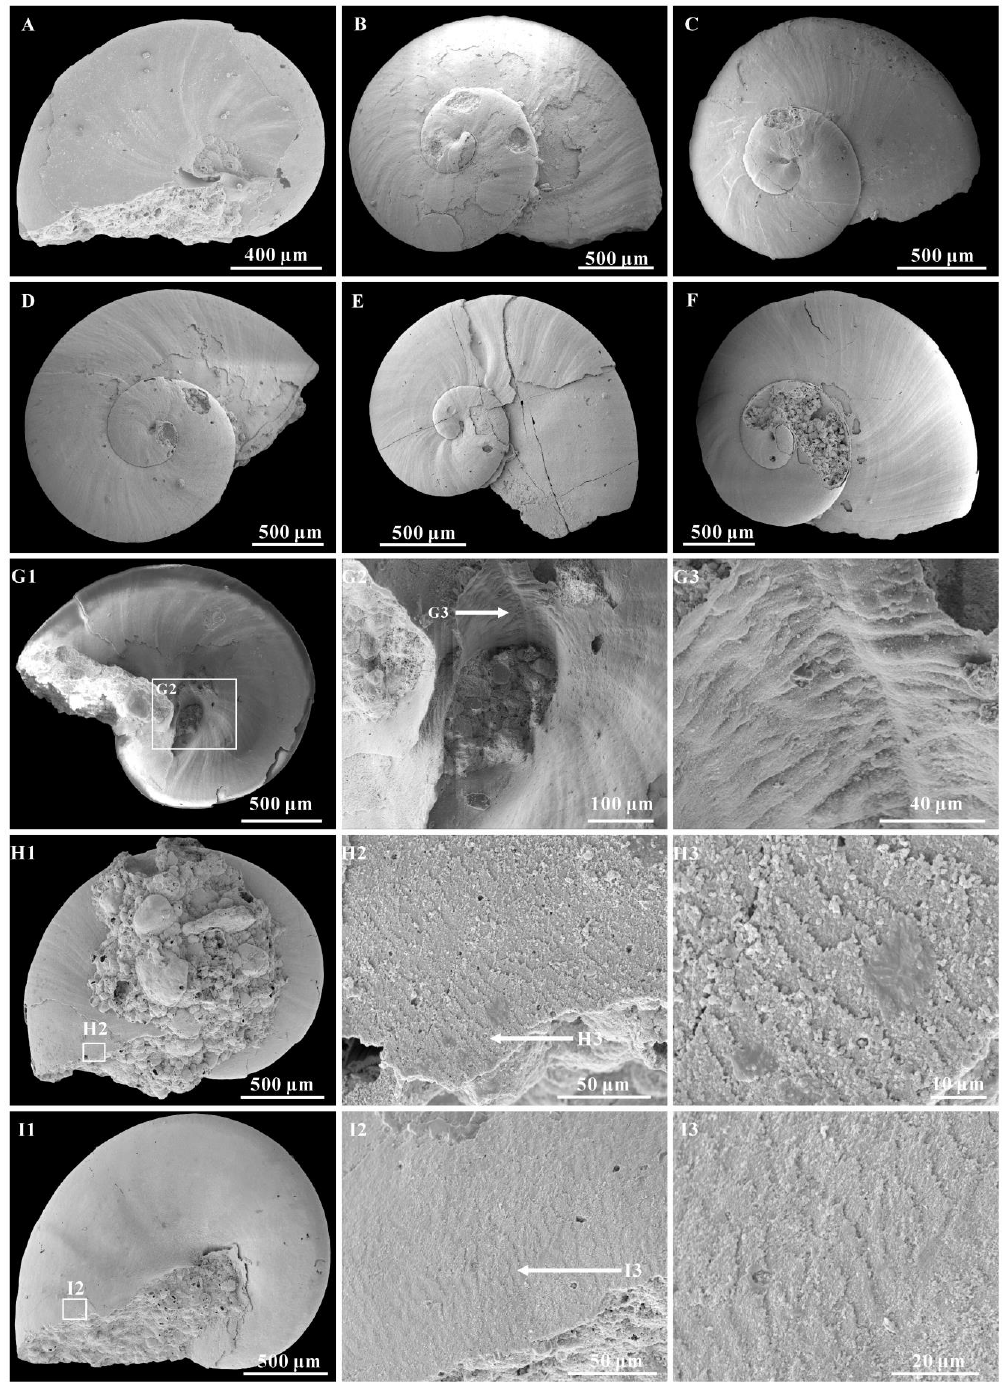
Figure 3. The growth lines and microstructure on the Aldanella attleborensis . ( A ), internal mold with external coating, umbilical view, CUBar11-10. ( B ), internal mold with external coating, apical view, CUBar249-7. ( C ), internal mold with external coating, apical view, CUBar249-8. ( D ), internal mold with external coating, apical view, CUBar249-17. ( E ), internal mold with external coating, apical view, CUBar250-3. ( F ), internal mold with external coating, apical view, CUBar250-4. ( G ), internal mold with external coating, umbilical view, CUBar98-10; ( G2 , G3 ) magnifications of ( G1 ) show- ing the special ornamentation of umbilical areas. ( H ), internal mold, umbilical view, CUBar208-8; ( H2 , H3 ) magnifications of ( H1 ) showing the laminar microstructure. ( I ) internal mold, umbilical view, CUBar208-4; ( I2 , I3 ) magnifications of ( I1 ) showing the laminar microstructure. ( A , G – I ) from Yanjiahe Section, ( B – F ) from Gunziao